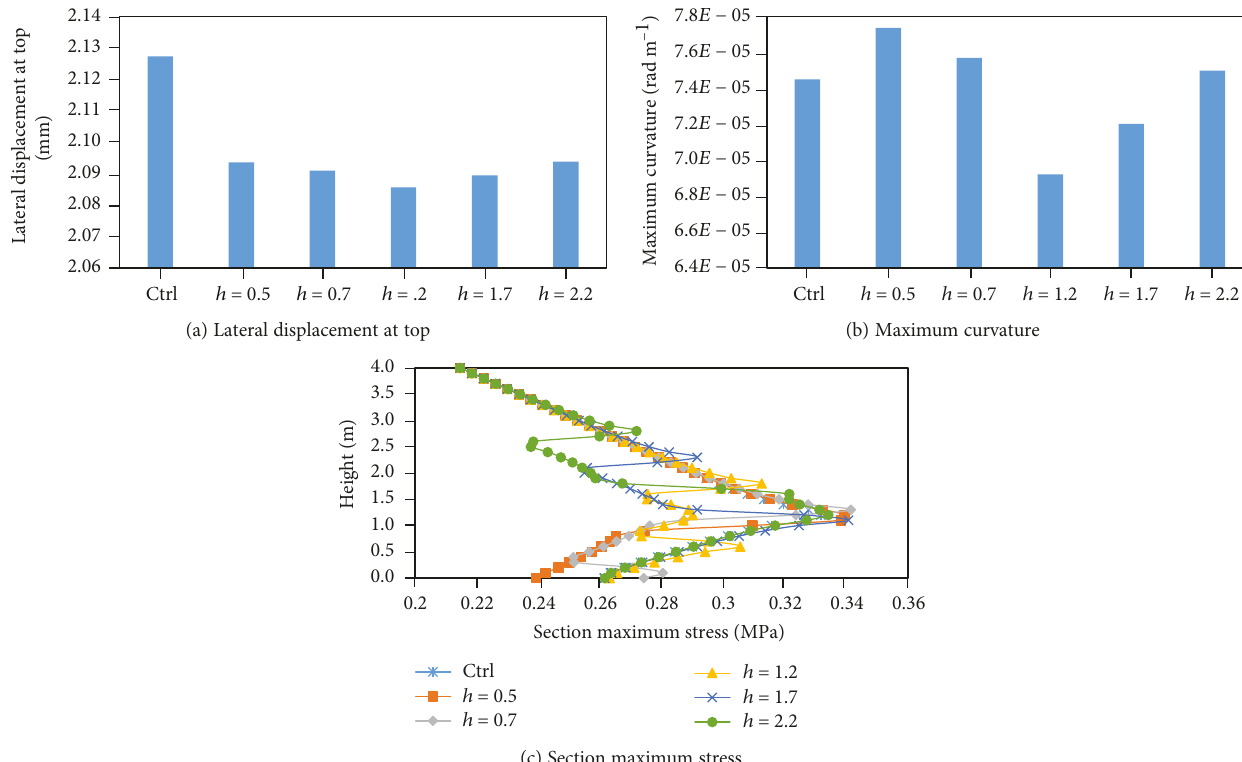
Figure 9: E ff ects of di ff erent FRP wrap locations: (a) lateral displacement at the top of the stem, (b) maximum curvature, and (c) section maximum stress (Ctrl =stem model with no FRP wraps; h =mid-height of FRP wrap, unit: